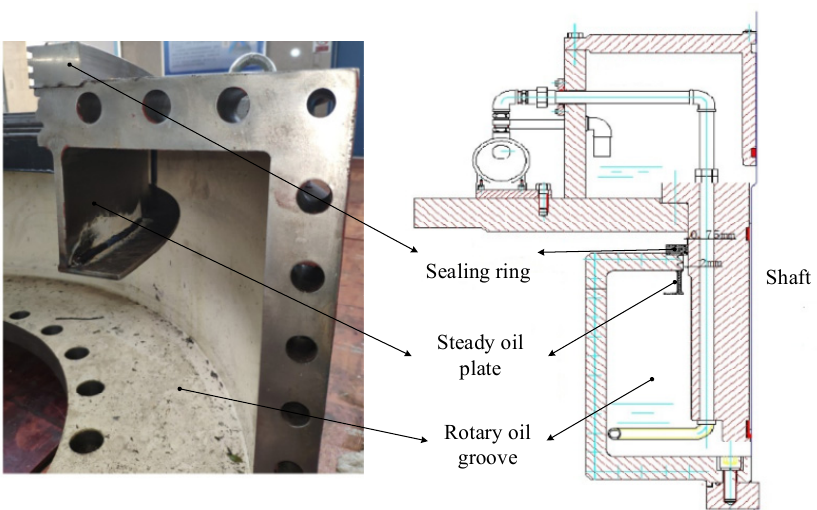
Figure 6. Steady oil plate and sealing ring installed after the renovation of oil tank [19] (modified according to reference [19]).